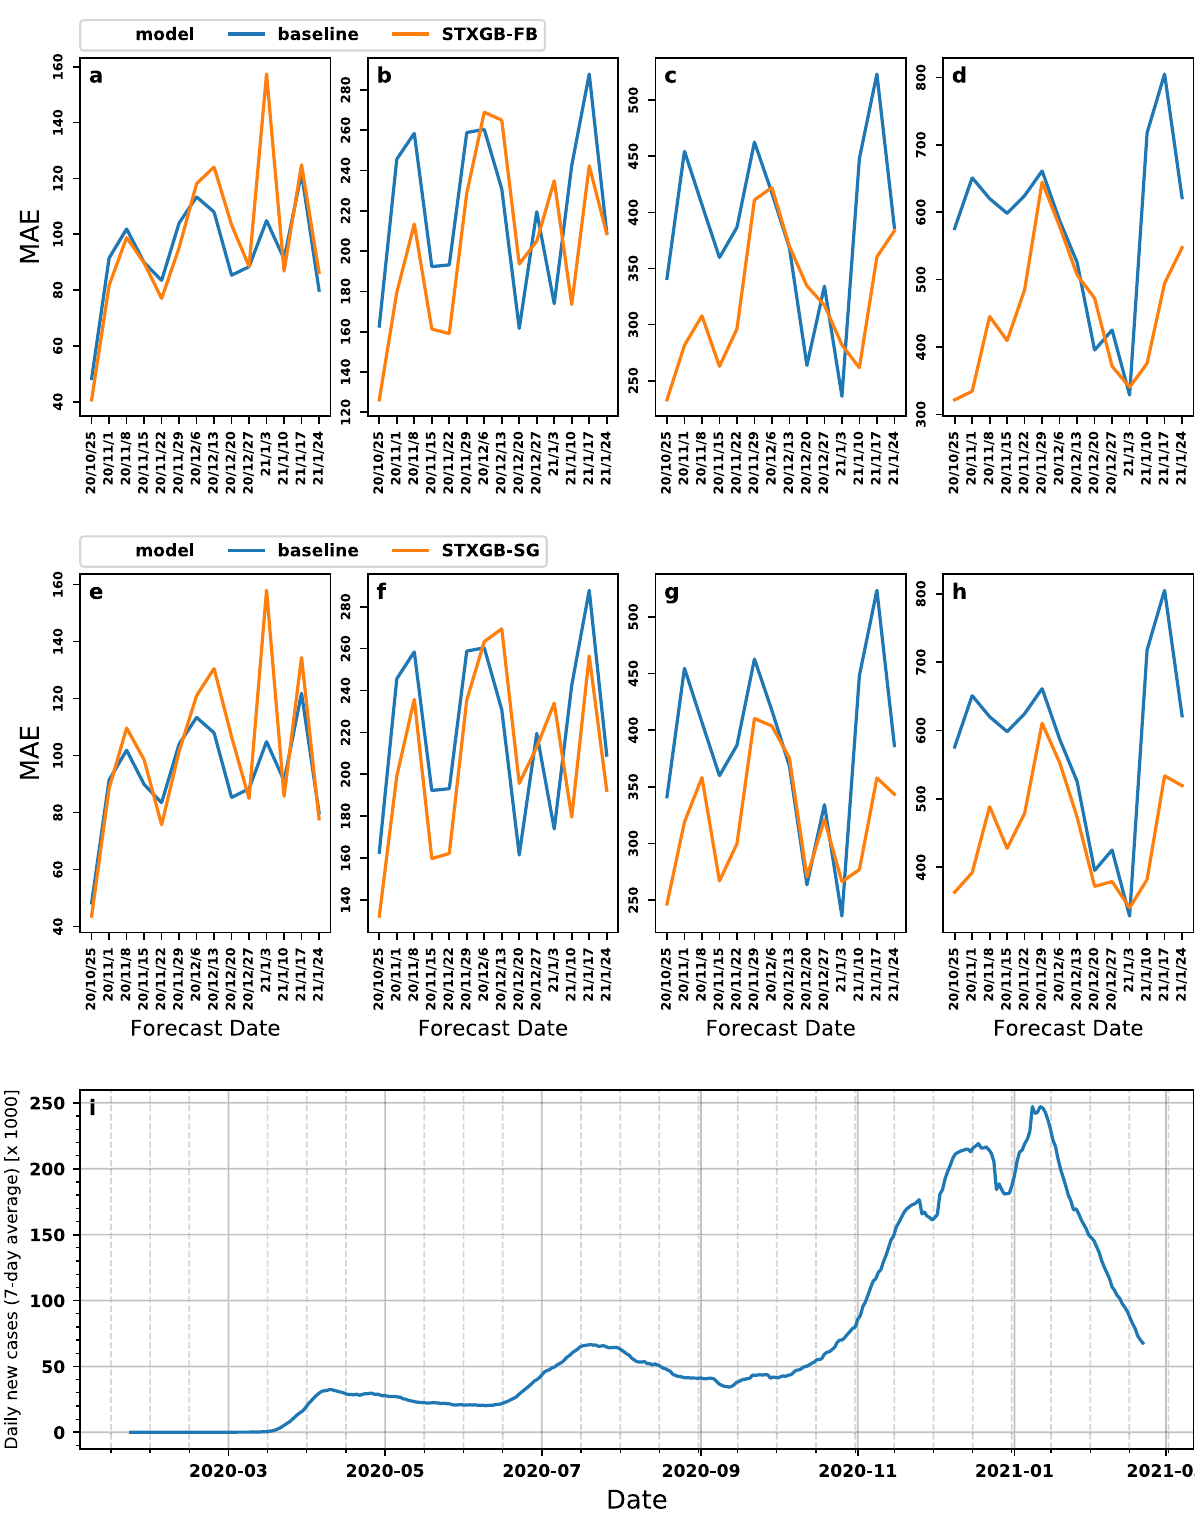
Fig. 2 Prediction-error comparison with COVIDhub-Baseline. Prediction MAEs of ( a – d ) STXGB-FB and ( e – h ) STXGB-SG models compared with the COVIDhub-Baseline model over four prediction horizons on 14 forecasting dates. a and e One-week horizon, and b and f two-week horizon, c and g three-week horizon, d and h four-week horizon. In each plot, MAE values are calculated as the error in predicting the total number of new cases. i Daily new cases in the coterminous United States. The values represent the 7-day average of total new cases reported in each day during our study